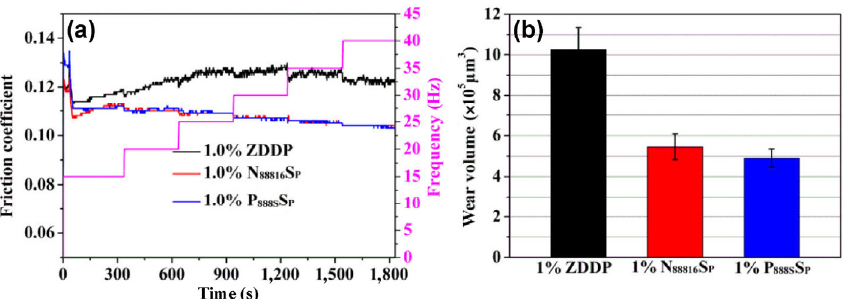
Fig. 6 Friction-reducing and anti-wear properties of ZDDP, N 88816 S P , and P 888S S P at mass concentration of 1.0% for steel/steel contacts at 300 N and 25 Hz when the frequency varies from 15 Hz to 40